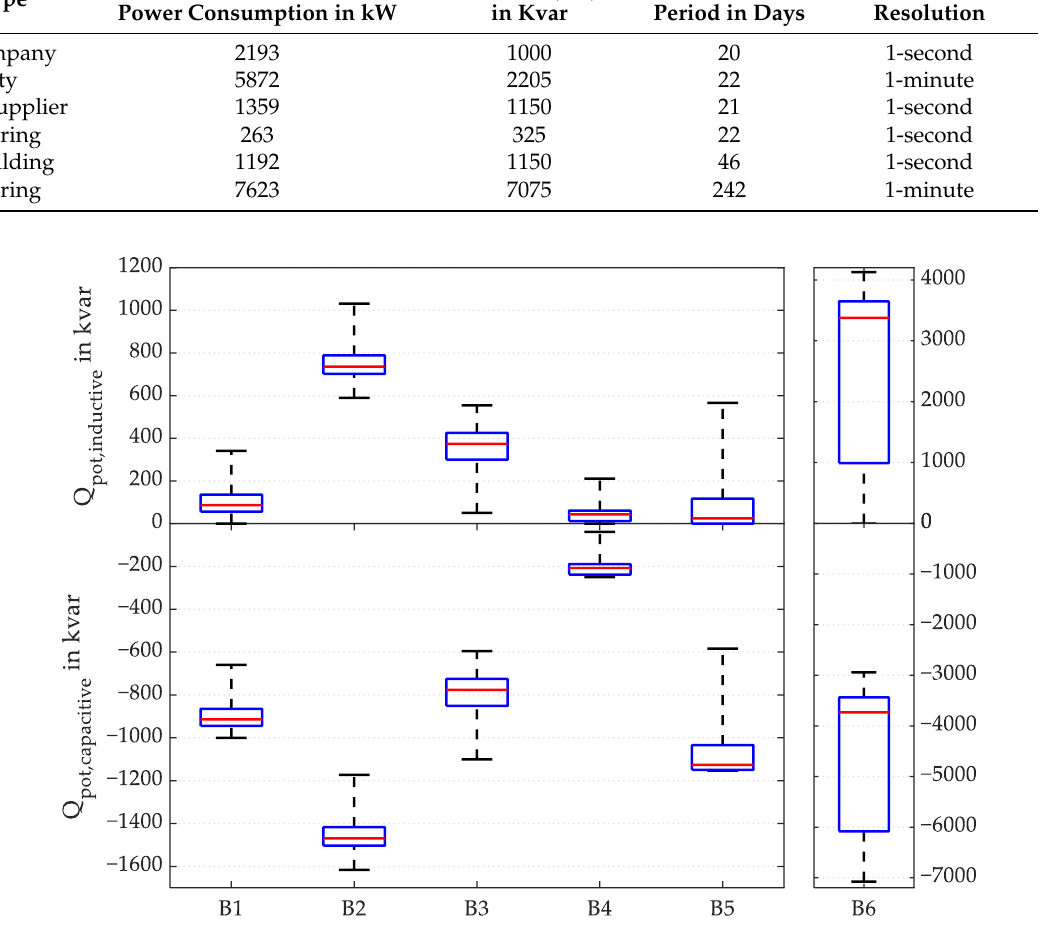
Figure 2. Inductive and capacitive reactive power potential of six measured industrial companies dis-